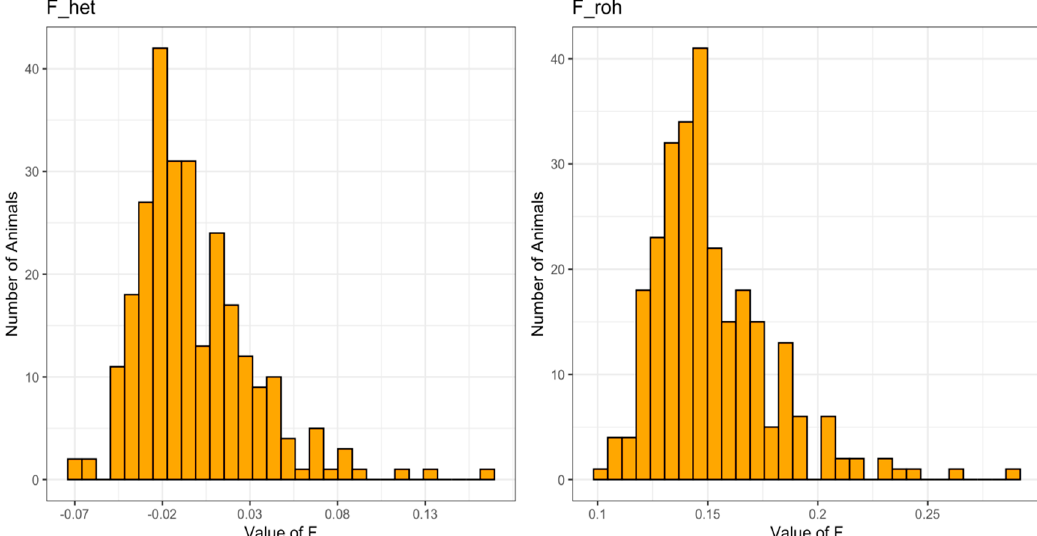
Figure 2. Distribution of genomic inbreeding coefficients based on the comparison of observed and expected homozygous genotypes (F_het) and on ROH (F_roh) in genotyped individuals.